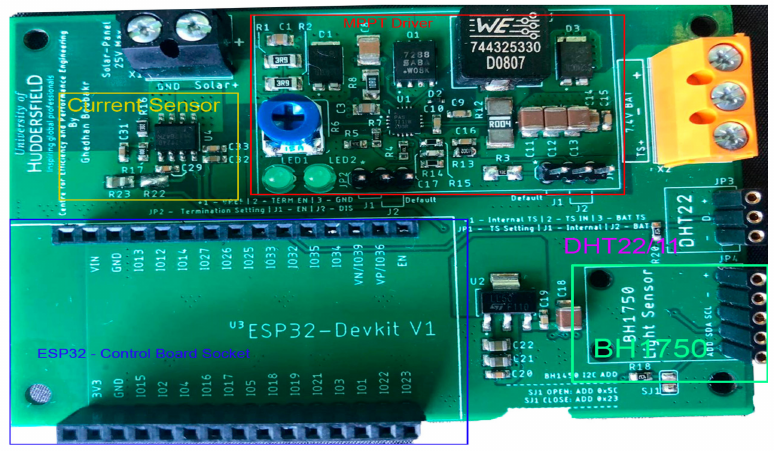
Figure 3. The PCB of the control circuit of the IoT monitoring system.